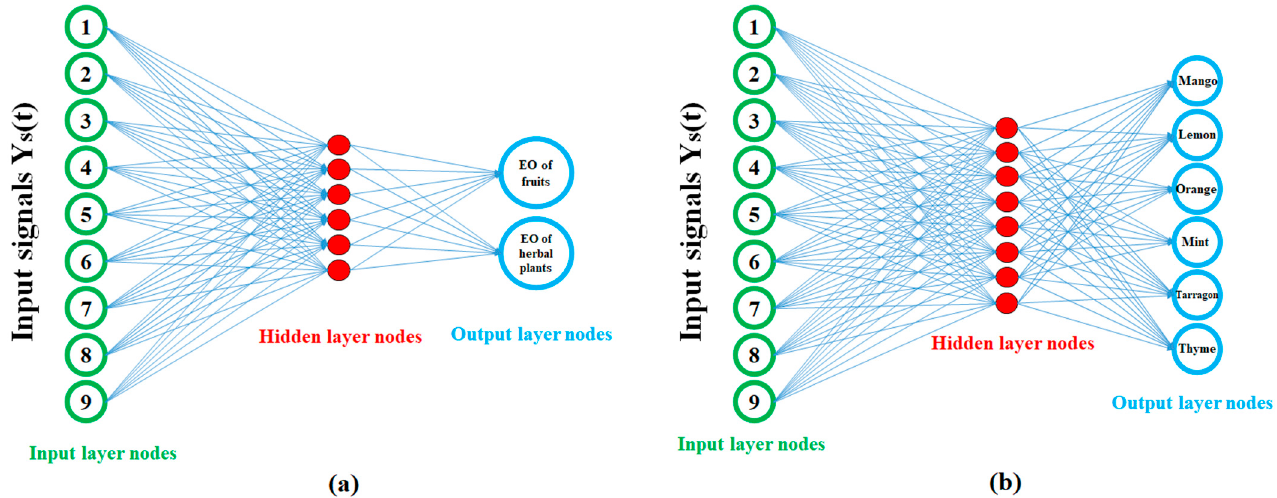
Figure 5. The ANN structure developed for classification and identification of essential oil sample types from e-nose output data. Separate methods with a different number of hidden layer nodes were used for: ( a ) 2-group classification (for discriminating between fruit and herbal essential oil types), and ( b ) 6-group classification (for discriminating between all six essential oil sample types analyzed).